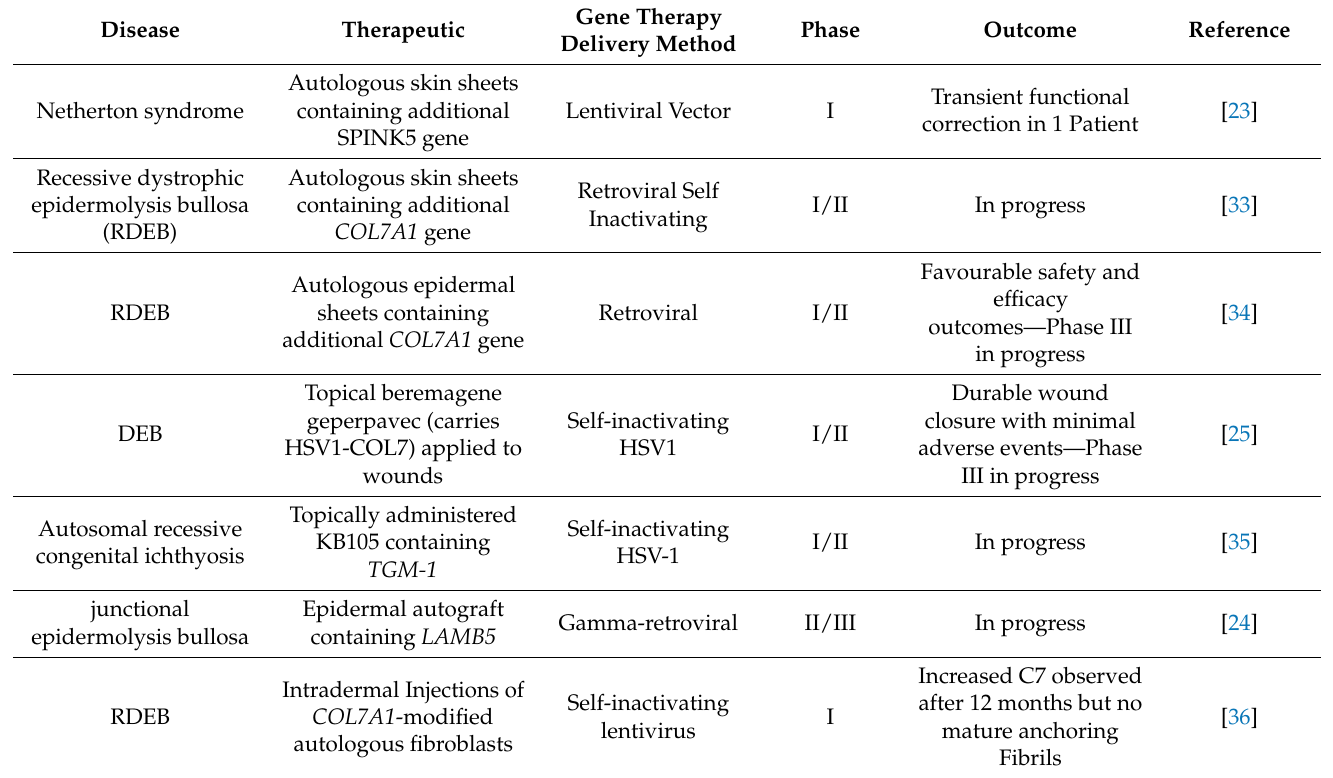
Table 1. Gene therapy trials in genodermatoses as listed on ClinicalTrials.gov (accessed on 29 November 2022) with reported results or in